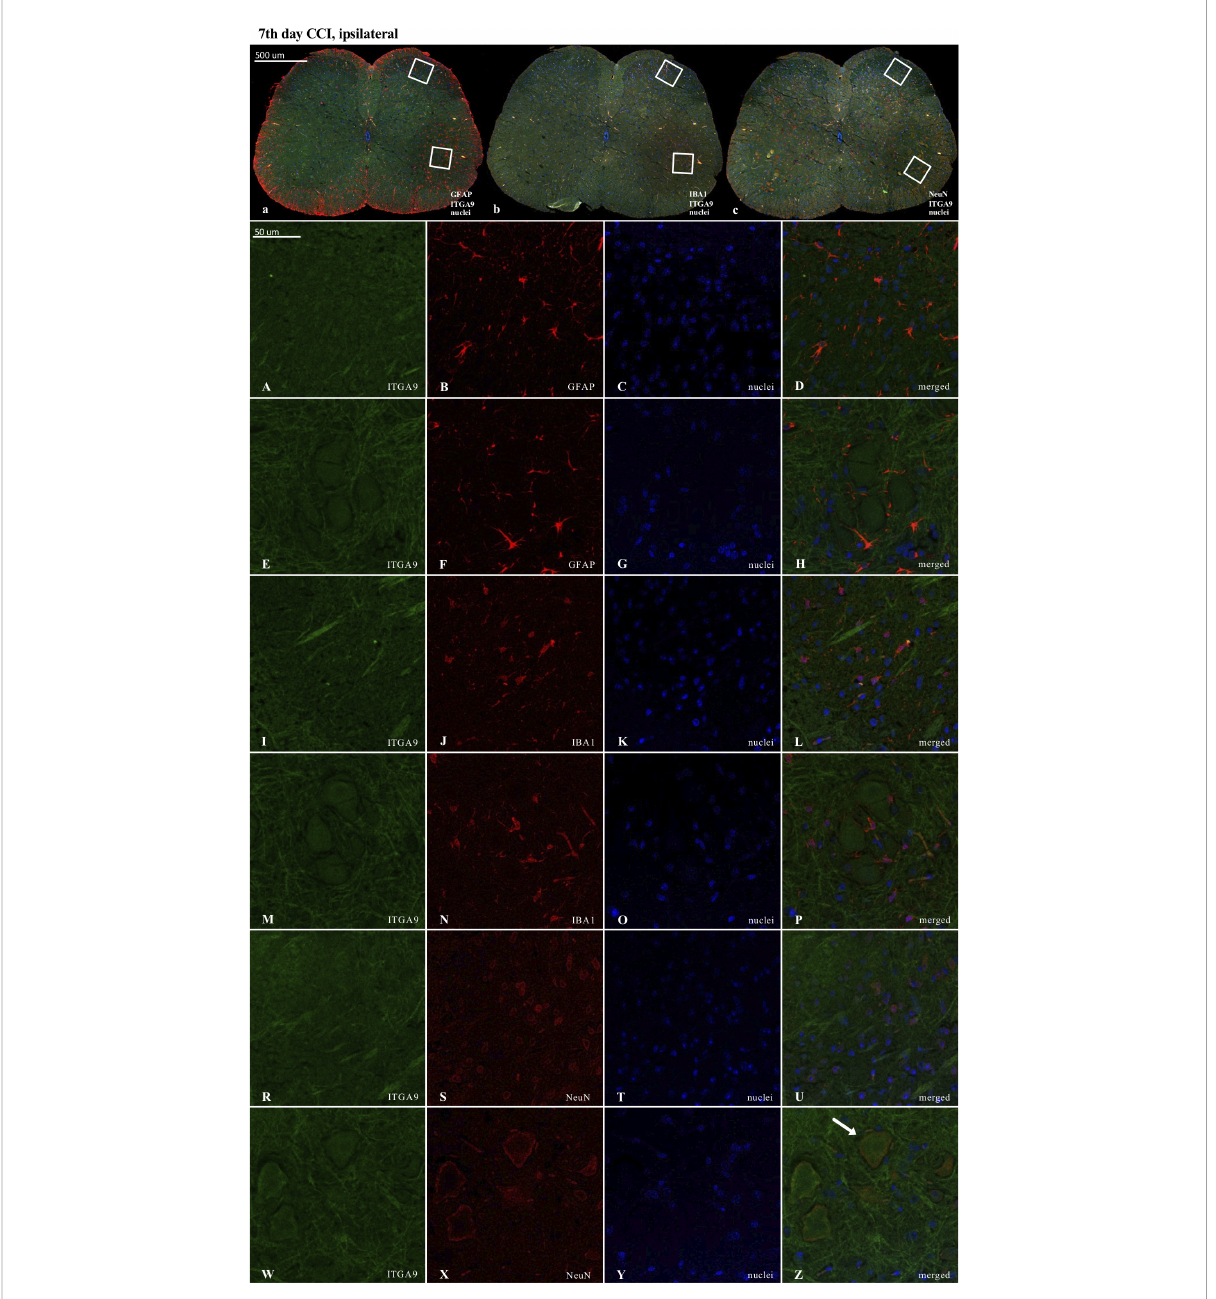
FIGURE 10 Immuno fl uorescence analysis of integrin alpha-9 (ITGA9) localization in the lumbar (L4 to L6) spinal cord 7 days after chronic constriction injury (CCI) of the sciatic nerve in mice. Dorsal (A – D, I – L, R – U) and ventral (E – H, M – P, W – Z ) parts of lumbar spinal cord ( a,b,c ) were shown as an approximate fragments of selected images. Representative immuno fl uorescence images from colocalization analysis performed on spinal cord, paraf fi n-embedded 7 m M microtome slices: ITGA9 (green: A, E, I, M, R, W ) with astroglia marker glial fi brillary acidic protein; (GFAP, red: B, F ); microglia marker ionized calcium-binding adaptor molecule 1; (IBA1, red: J, N ); and with neuronal marker neuronal nucleus; (NeuN, red: S, X ), Nuclei are in blue ( C, G, K, O, T, Y ). High magni fi cation, three-dimensional image rendering shows ITGA9 localization inside NeuN-positive cells (yellow: U, Z ). Scale bars: 50 m m ( a, b, c ), 500 m m (A – Z)